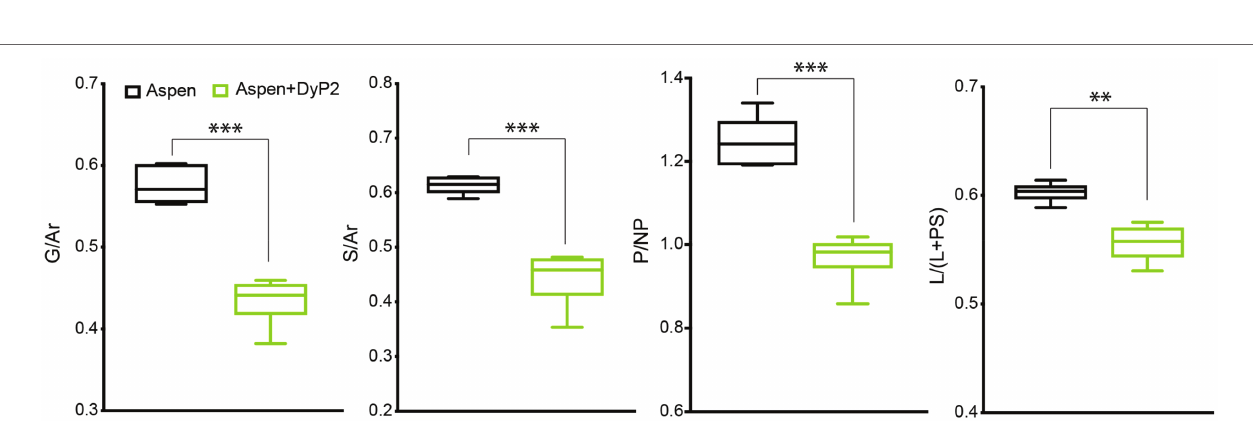
FIGURE 3 | Modification of lignin in aspen wood powder by DyP2. Reactions were performed at 40 ° C. Lignin modification metrics, G/Ar, S/Ar, P/NP, and L/(L + PS) ratios are presented, from left to right. Data are based on six ToF-SIMS spectra of each treatment ( n = 6); ANOVA analysis with Tukey’s post-test: ** p < 0.005; *** p < 0.0001, compared to the no-enzyme